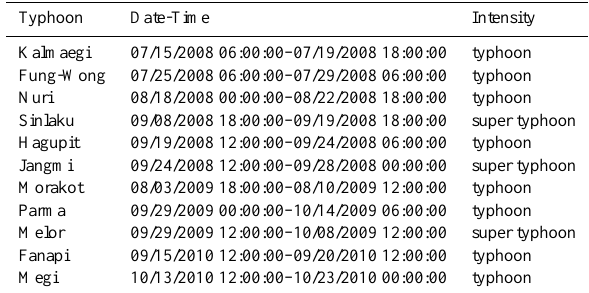
Table 1. List of typhoon cases between 2008 and 2010 over the western North Pacific